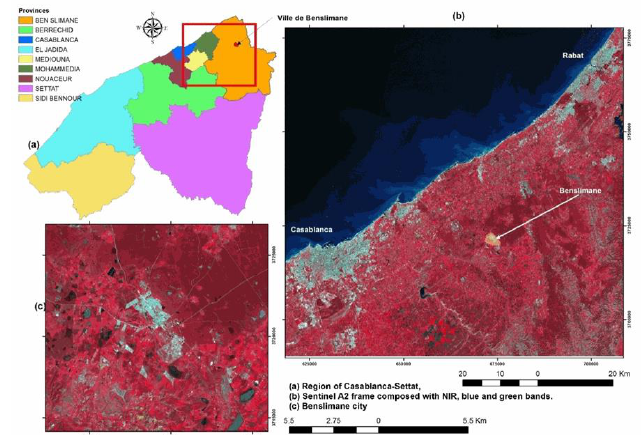
Figure 5. Location of the study area on a Sentinel A2 background